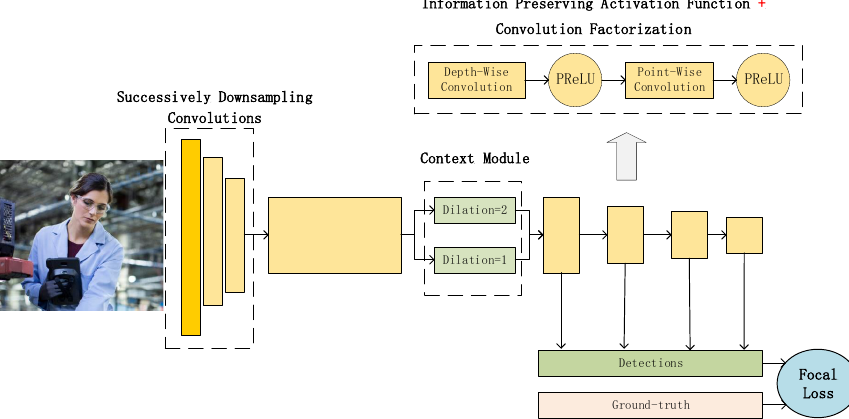
Figure 1. The overview of the network architecture of EagleEye face detector. The detection network is built using the information preserving activation function and the convolution factorization in almost all the backbone layers and the predicting